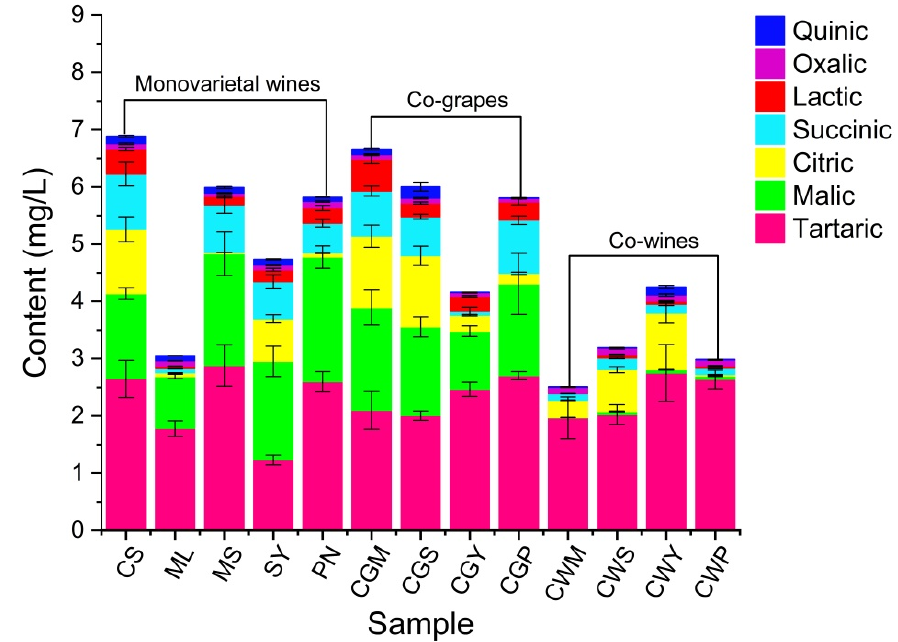
Figure 1. The organic acid content of wine samples from different varieties and blending methods. The monovarietal wine: Cabernet Sauvignon (CS), Merlot (ML), Marselan (MS), Syran (SY) and Point Noir (PN); (CGM (CS:ML = 80:20), CGS (CS:MS = 80:20), CGY (CS:SY = 80:20), CGP (CS:PN = 80:20)) by co ‐ grape treatment; CLM1 (CS:ML = 90:10), CLM2 (CS:ML = 80:20), CLM3 (CS:ML = 70:30) by co ‐ wines treatment.